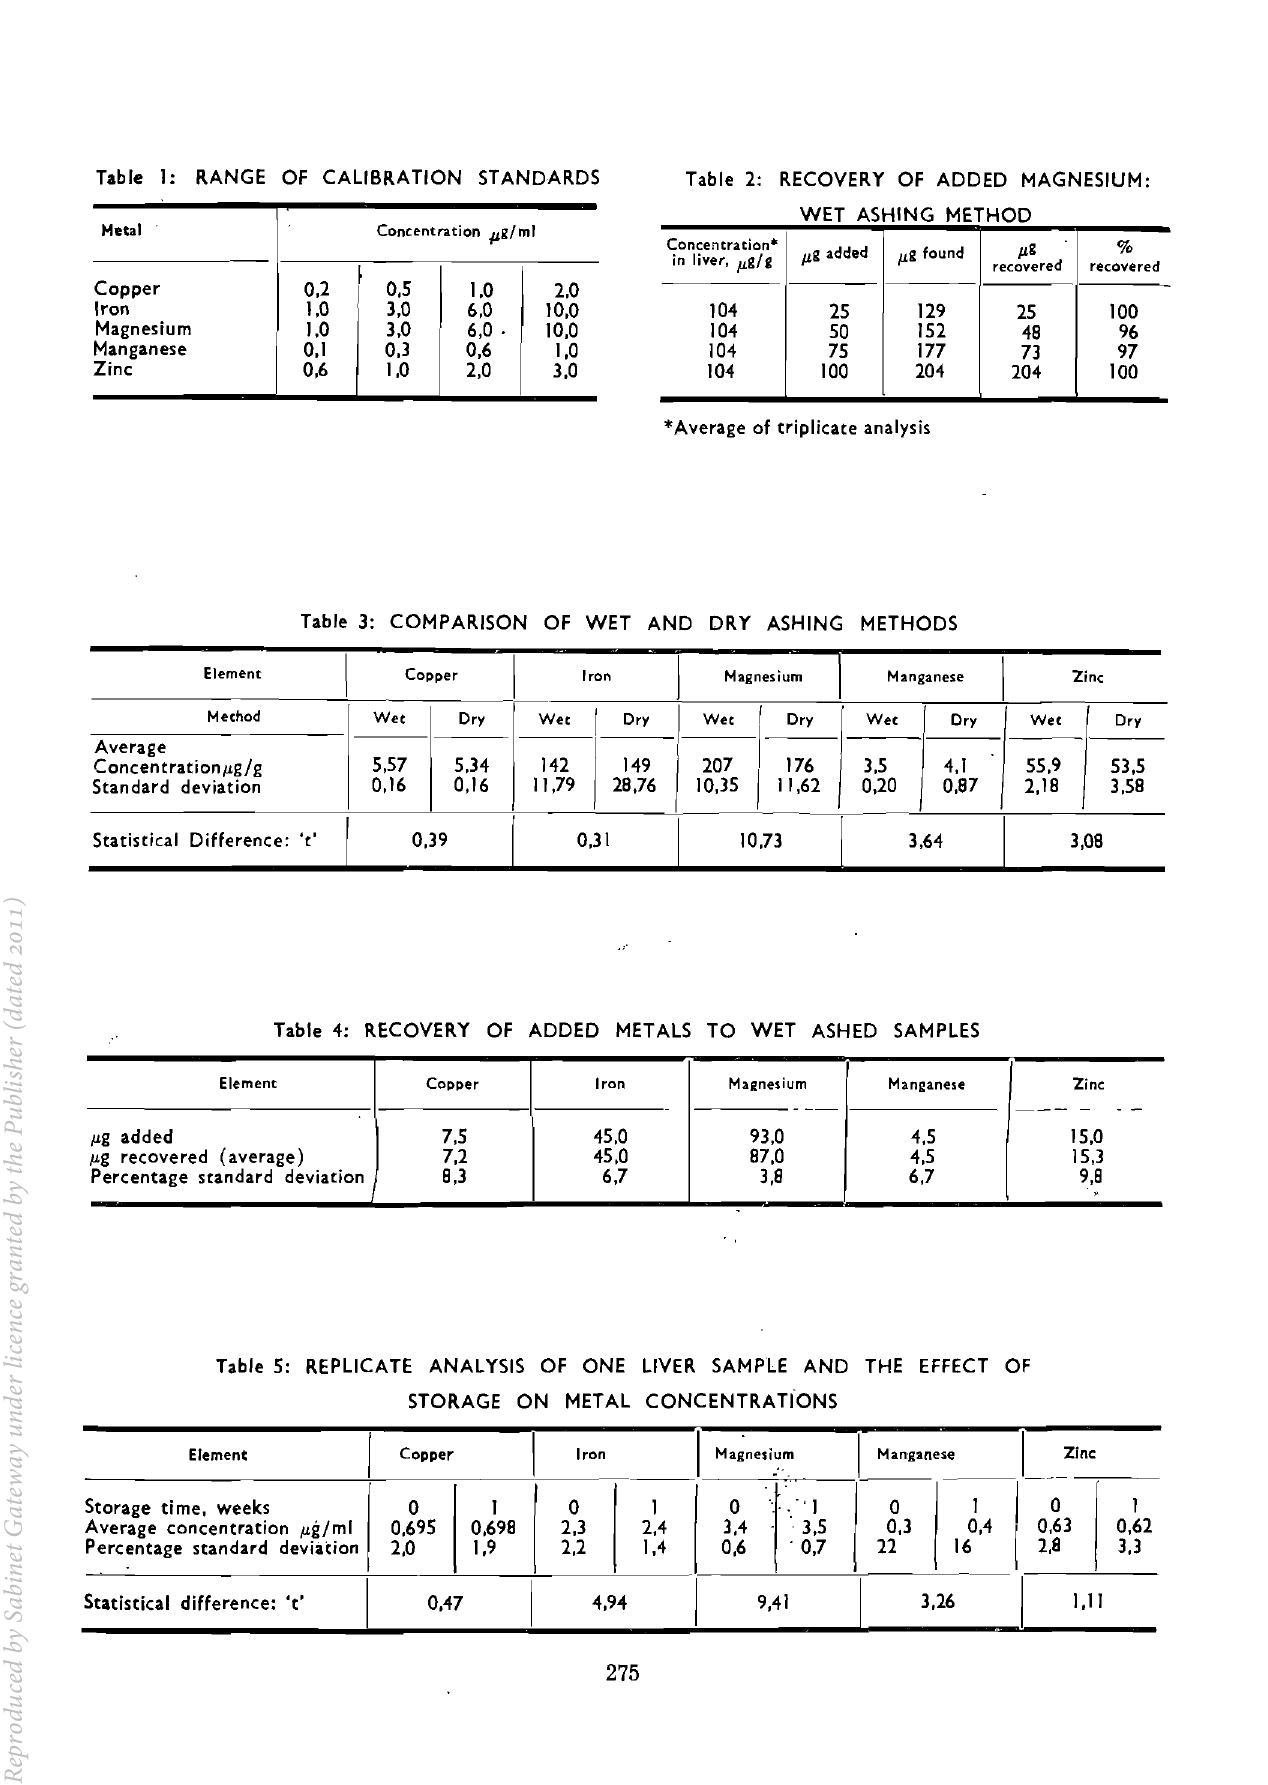
Table I: RANGE OF CALI BRA T/ON STANDARDS Table 2: RECOVERY OF ADDED MAGNESIUM: